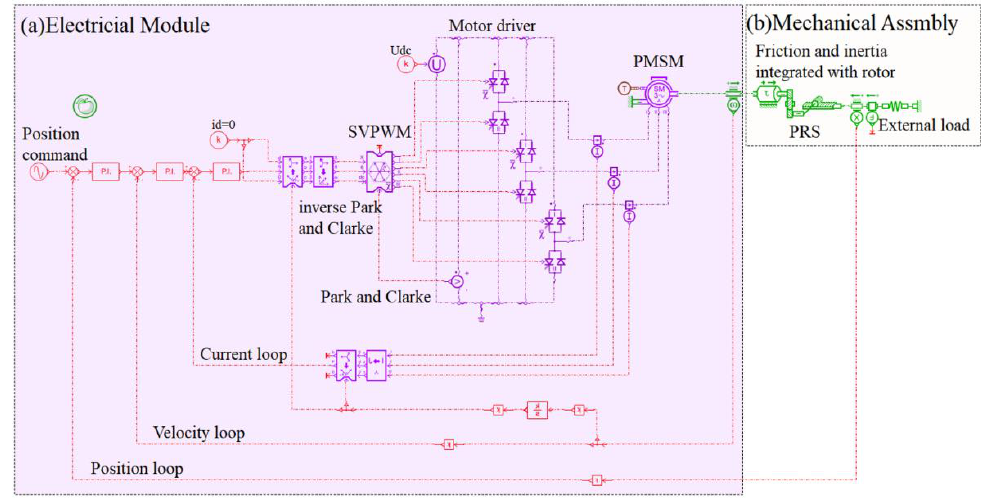
Figure 4. The simulation model of